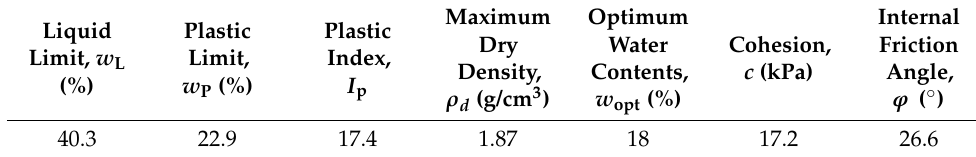
Figure 2. Pines on slopes of the small watershed of Reshui River. ( a ) Photo of shallow landslides; ( b ) Pine trees dumped on the shallow landslide. Table 1. The physical mechanics of soil samples.